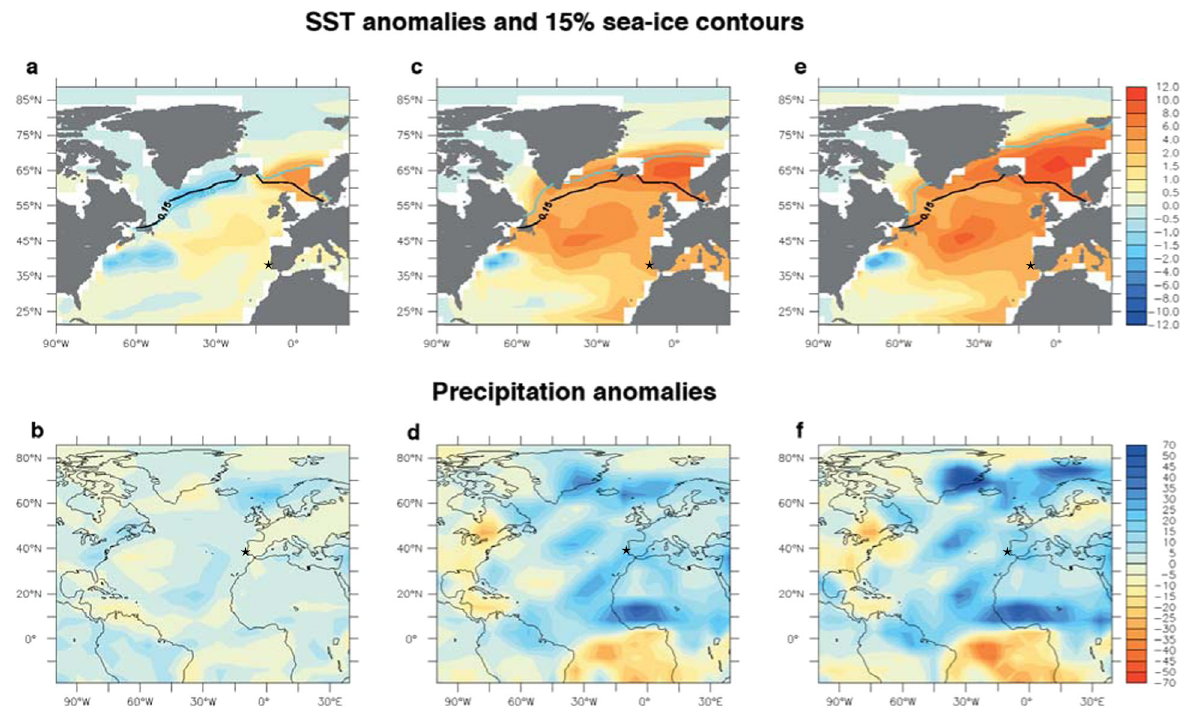
Fig. 7 Maps of annual mean SST and precipitation anomalies from full stadial conditions for three HS4 recovery phases in the LOVECLIM experiment. a SST anomalies (°C) and 15% sea-ice contour (full stadial in black, recovery in light blue) for 38.90 – 38.92 ka (model years 1060 – 1080) compared to